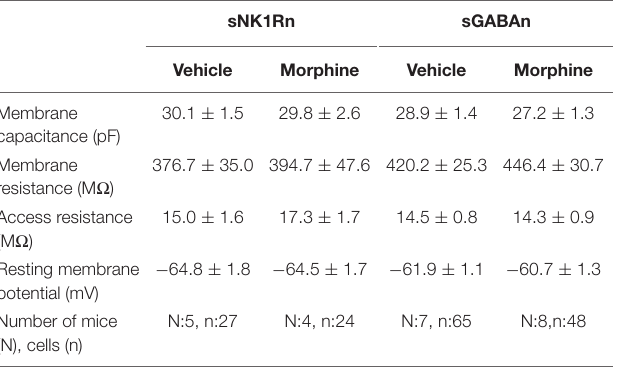
TABLE 1 | Comparison of the principal passive electrophysiological properties of vehicle and morphine treatments in sNK1Rn and sGABAn. sNK1Rn sGABAn Vehicle Morphine